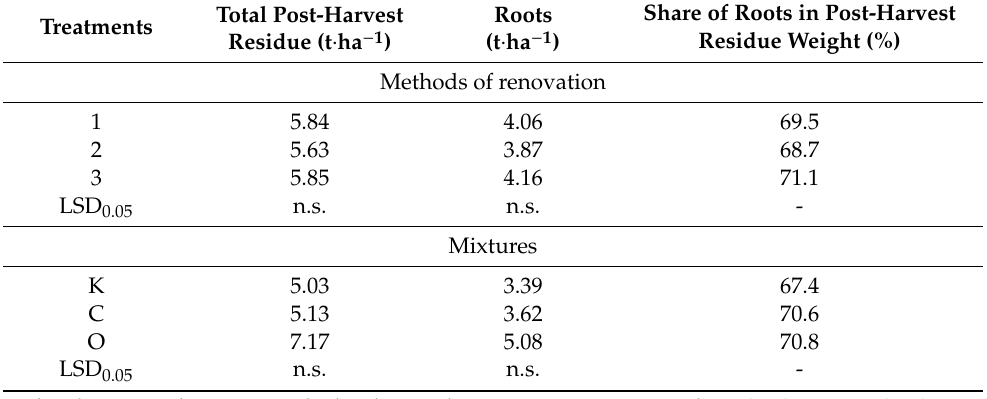
Table 4. Yield (t · ha − 1 ) and percentage of roots in the dry matter of post-harvest residues remaining after applying the legume–grass